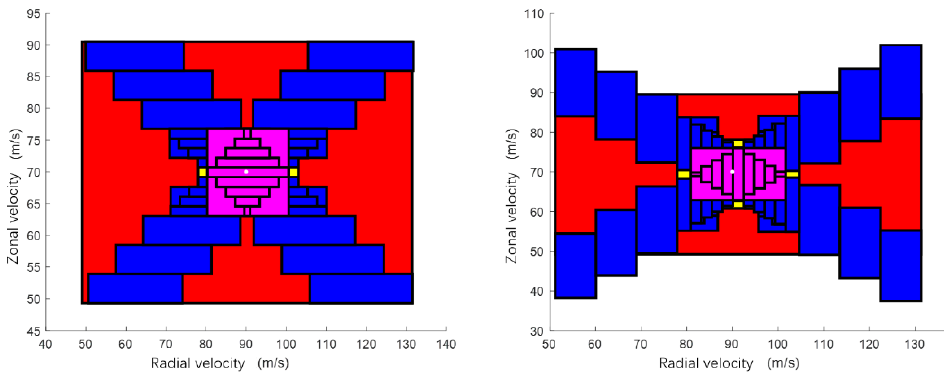
Figure 4. The results of Step Two and Step Three of the algorithm.